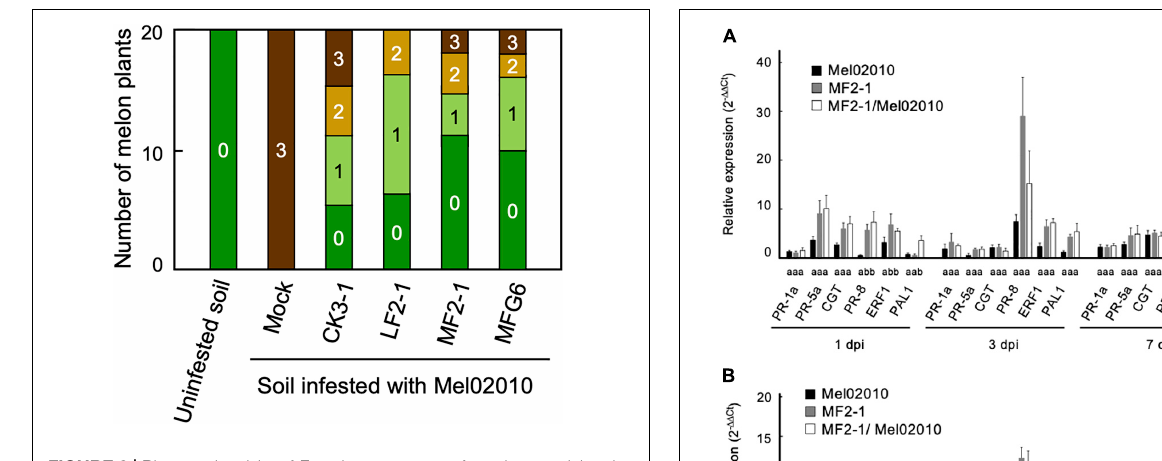
( Figure 4 ). These results indicated that the biocontrol effect lasted for at least 7 days.